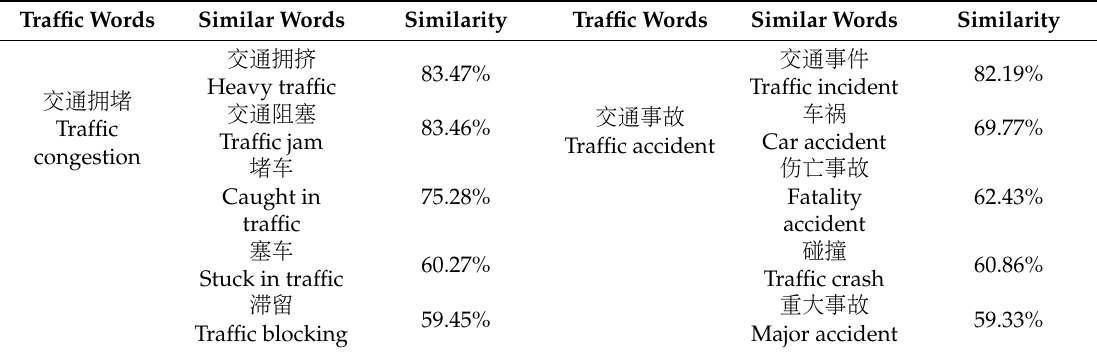
Table 3. Most similar words for traffic congestion and traffic accident ranked by transportation word2vec.